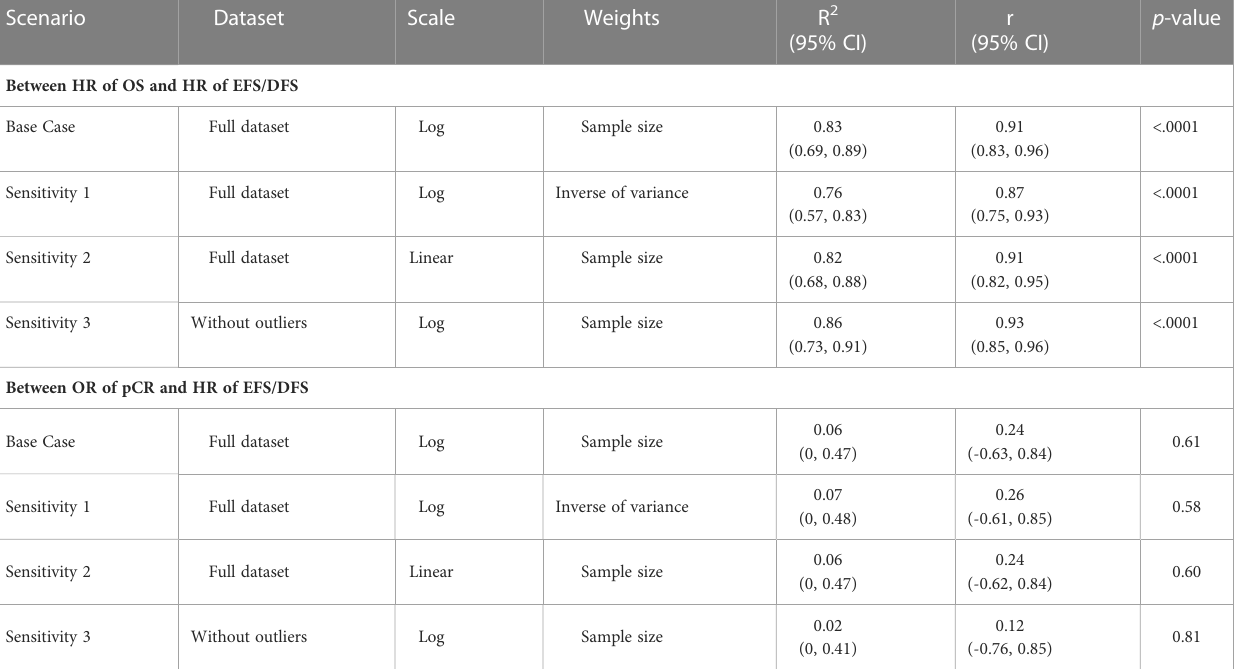
TABLE 1A Results of sensitivity analysis.